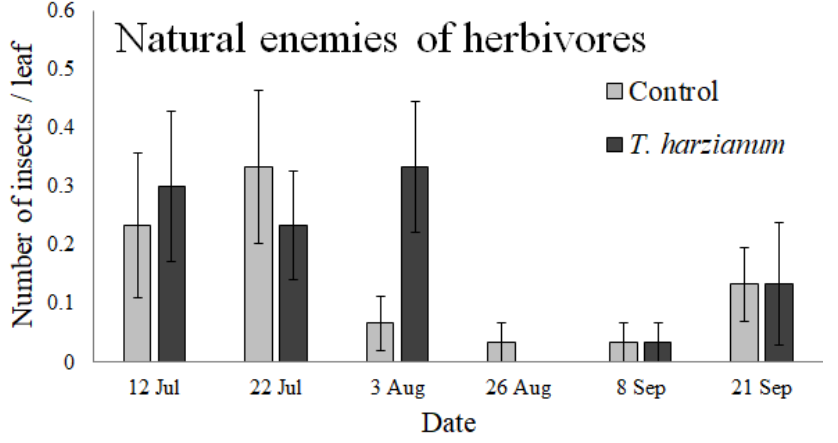
Figure 6. Mean values (± standard errors) of natural enemies of herbivores (predators and parasitoids) collected on tomato leaves during the experiment.